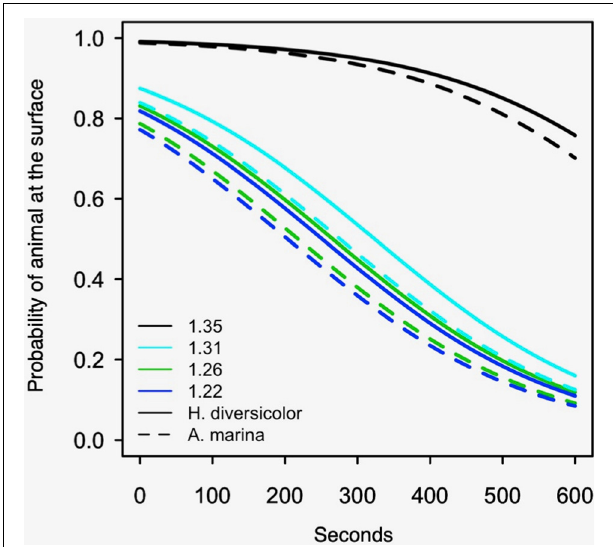
FIGURE 4 | Logistic regression models of polychaete burrowing, showing the probability of the polychaetes presence at the sediment surface for the first 600 s. The dotted lines are A. marina models and the solid lines are H. diversicolor . Results are shown for the sandy sediment with a bulk density (g cm − 3 ) of 1.35, 1.31, 1.26, and 1.22. The experiment was not performed with muddy sediment (see Methods section “Process Measurements: Burrowing Rates”).